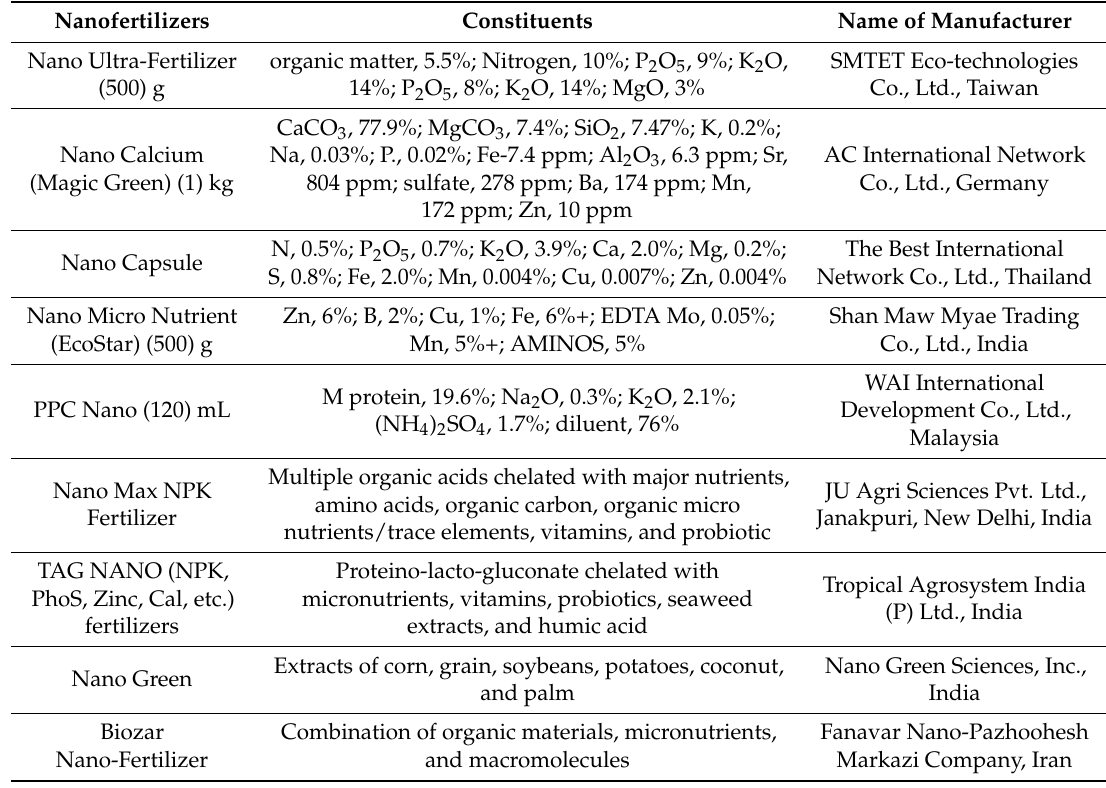
Table 2. Some approved nanofertilizers used in the world today and their compositions. Data from